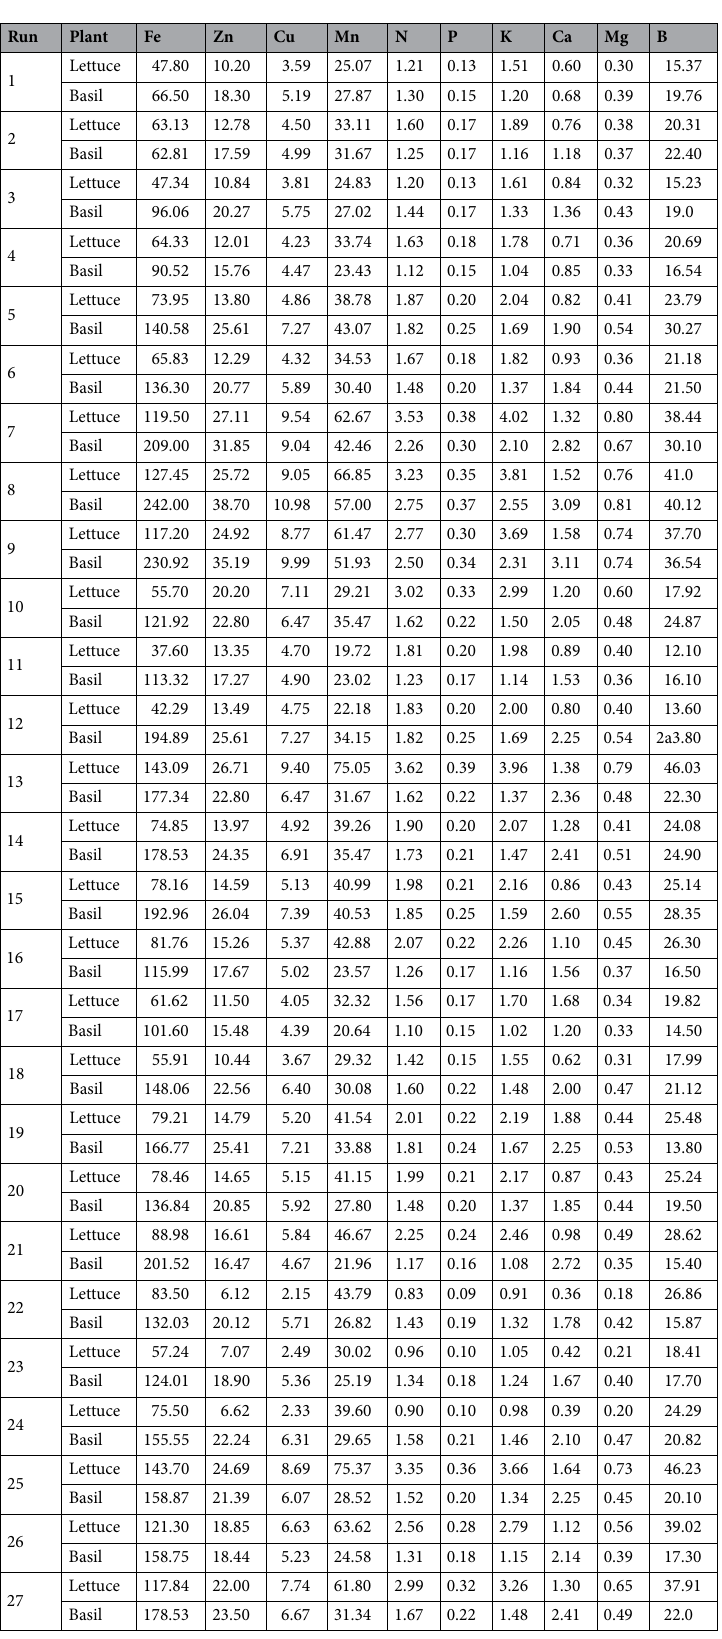
Table 6. The mean of measured Micro and elements in three replicates per each